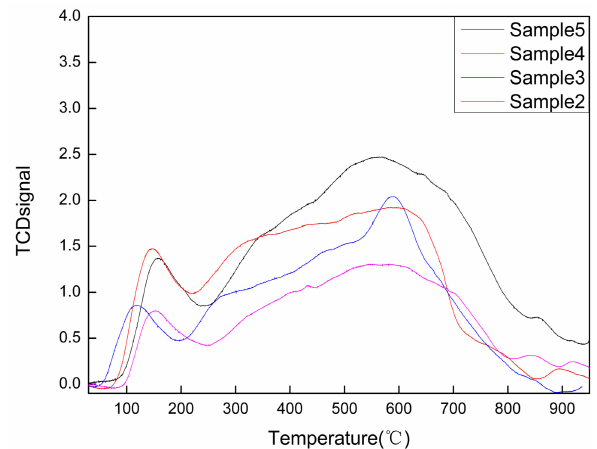
Figure 9. NH 3 -TPD diagram of modified rare earth concentrate.